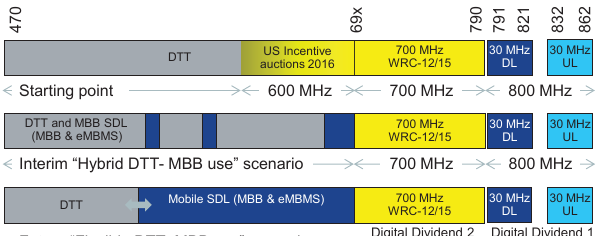
Figure 1. Evolution of the UHF band usage with the hybrid use